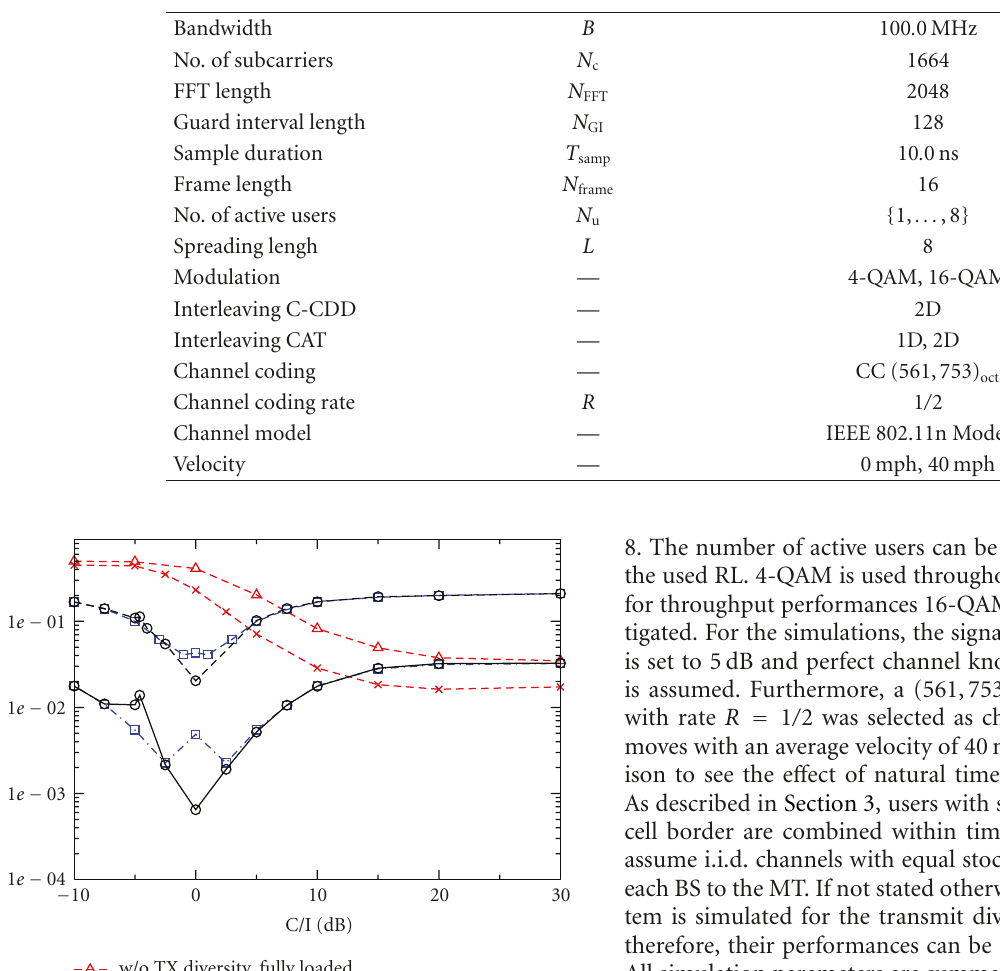
Table 1: Parameters of the cellular transmission systems.